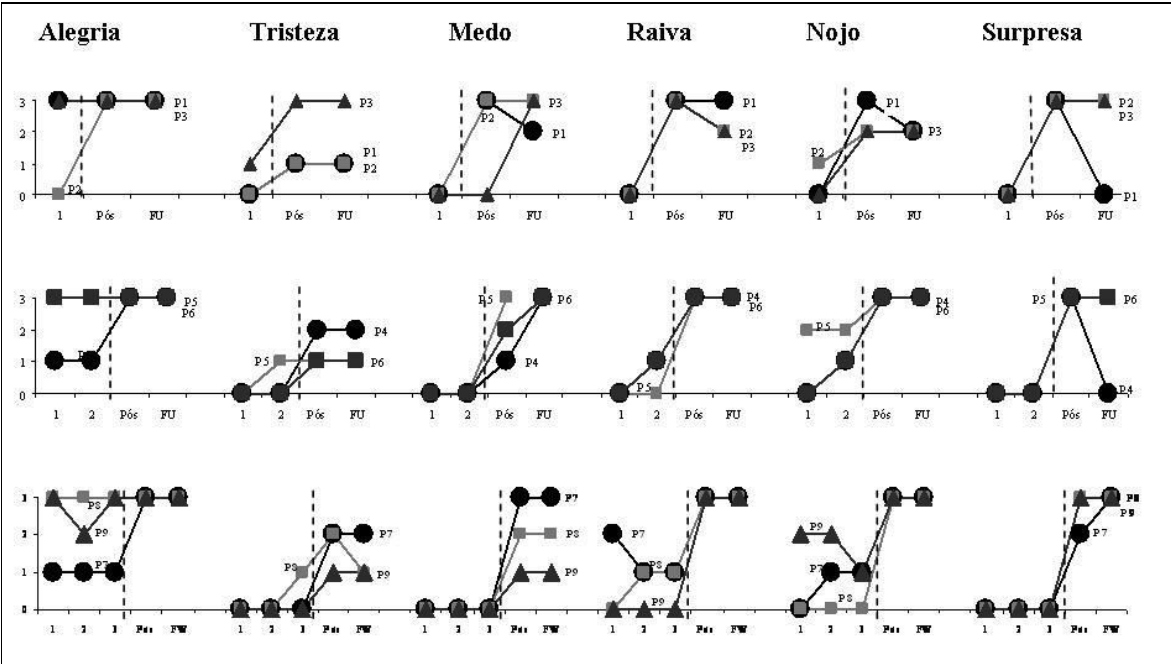
Figura 1 . Qualidade das EFE dos nove participantes, nas sondagens de Pré-teste 1, 2 e 3, Pós-teste e Follow-up , conforme avaliação por juiz com base em fotogra fi